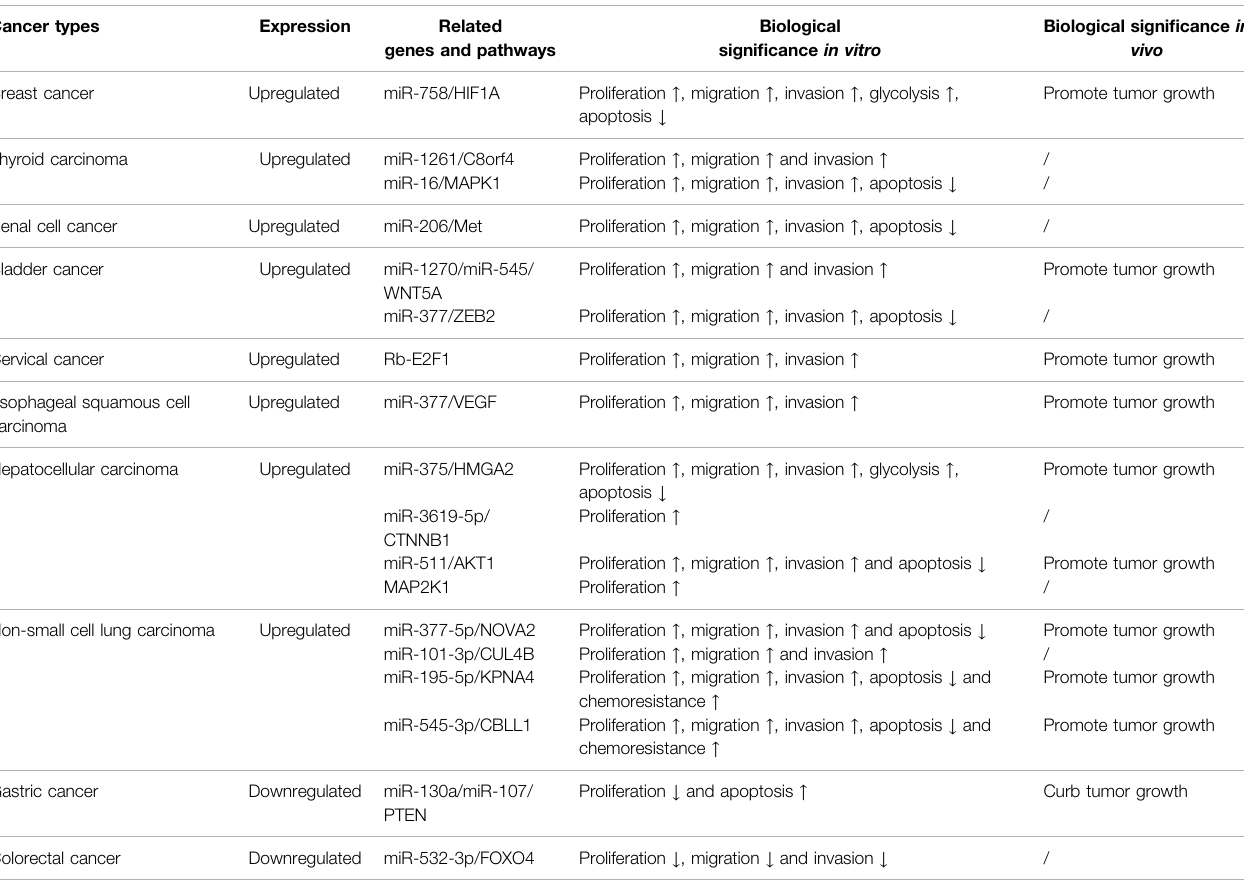
TABLE 1 | The expressions and regulation mechanisms of circRNA-ZFR on malignant